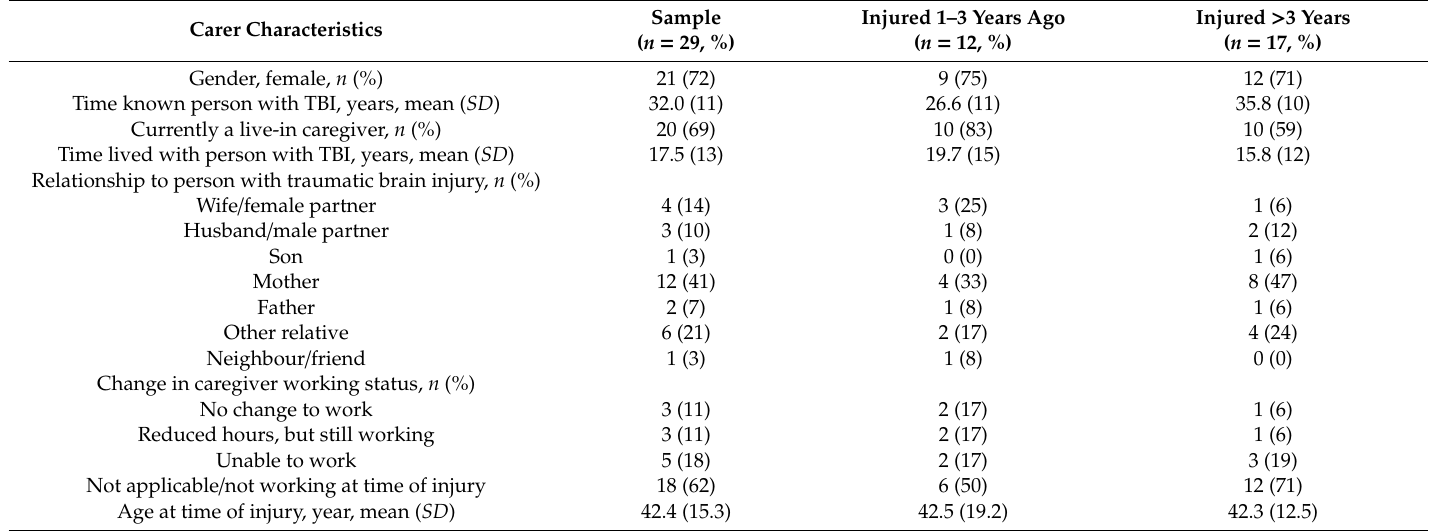
Table 1. Demographic characteristics of informal caregivers of people with a traumatic brain injury.